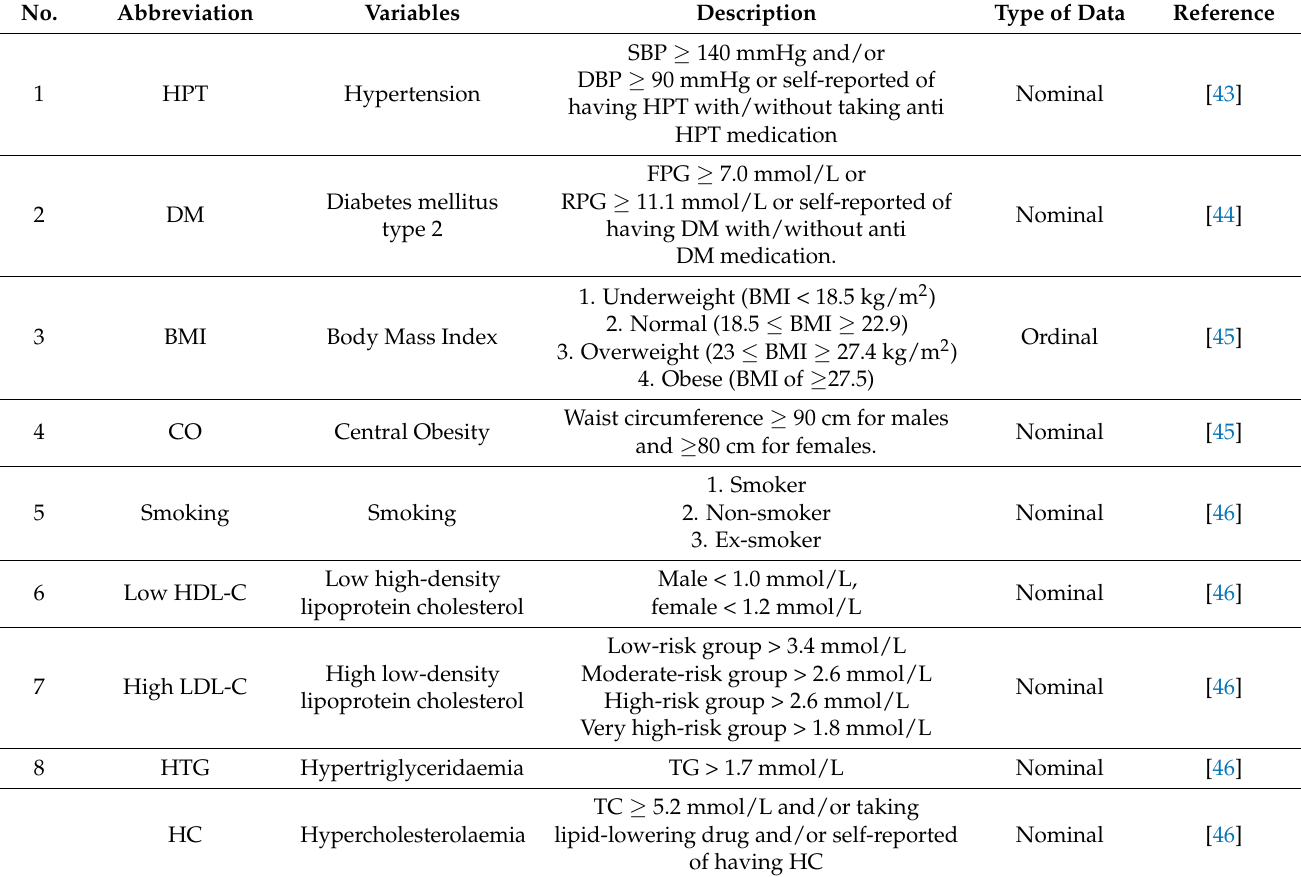
Table 1. Summary of variables